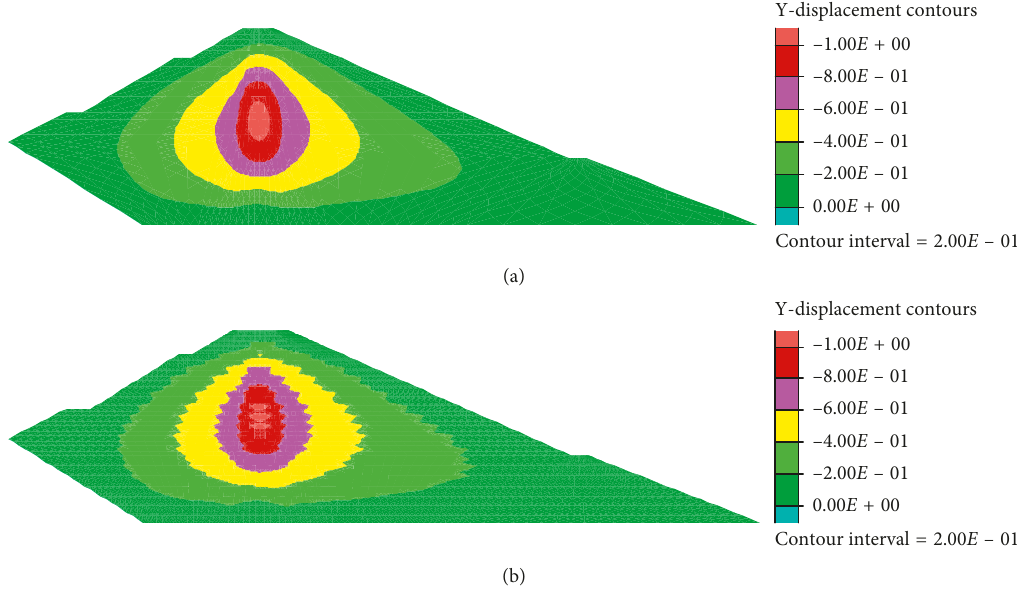
Figure 2: Vertical displacement of the first and the second samples. (a) Coarse mesh size. (b) Fine mesh size.